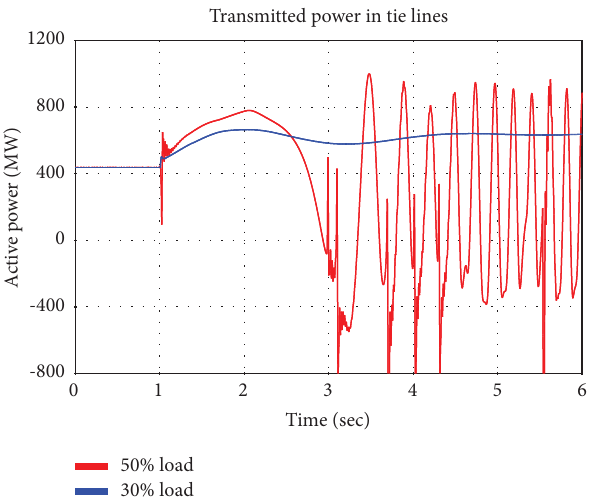
Figure 13: Power oscillations in tie lines for cases of 30% and 50% load increase.